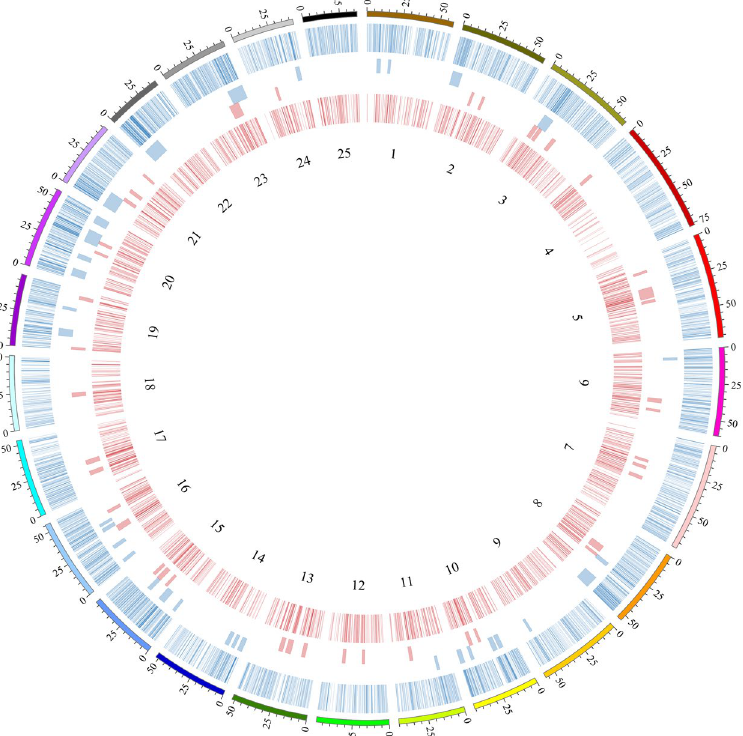
Figure 3. Differential methylation compared to differentially expressed genes. From outside to inside: A circular representation of the zebrafish chromosomes with the number of bases (Mbp), followed by differentially methylated regions (DMRs) with at least 10% difference (blue ring) and blue blocks indicating significant overrepresented clusters of DMRs. Pink blocks indicate overrepresented clusters of differentially expressed genes (DEGs) and the inner pink ring shows the locations of all DEGs (absolute fold change > 1.5).